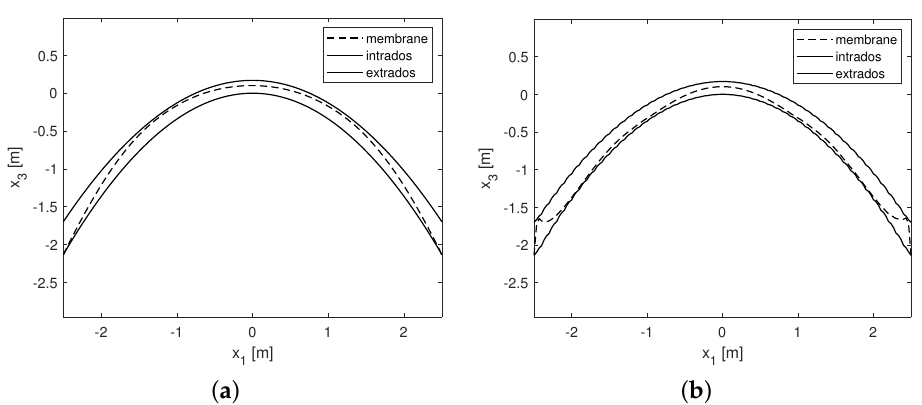
Figure 12. Sections of the vault and of the membrane surface along x 2 = 0 ( a ) and along the diagonal x 2 = − x 1 ( b ), after optimization with respect to the membrane boundary